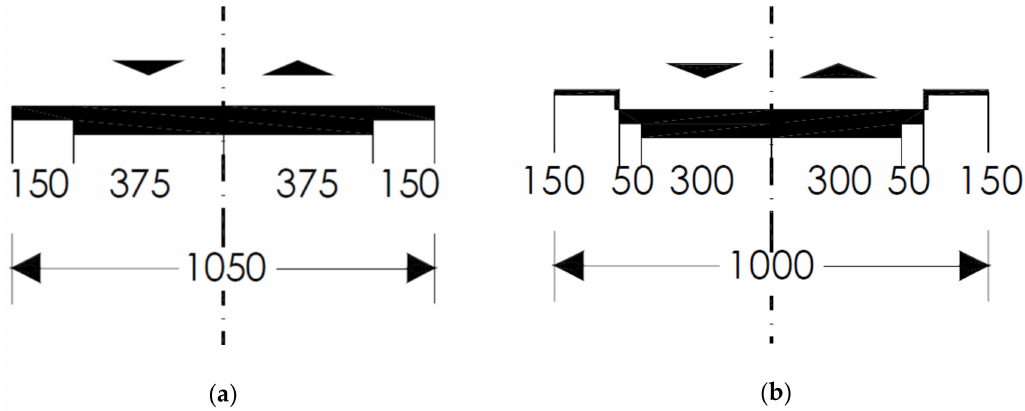
Figure 2. Italian two-lane road section ( a ) rural, road typology: “C1”; ( b ) urban, road typology: “E1”.